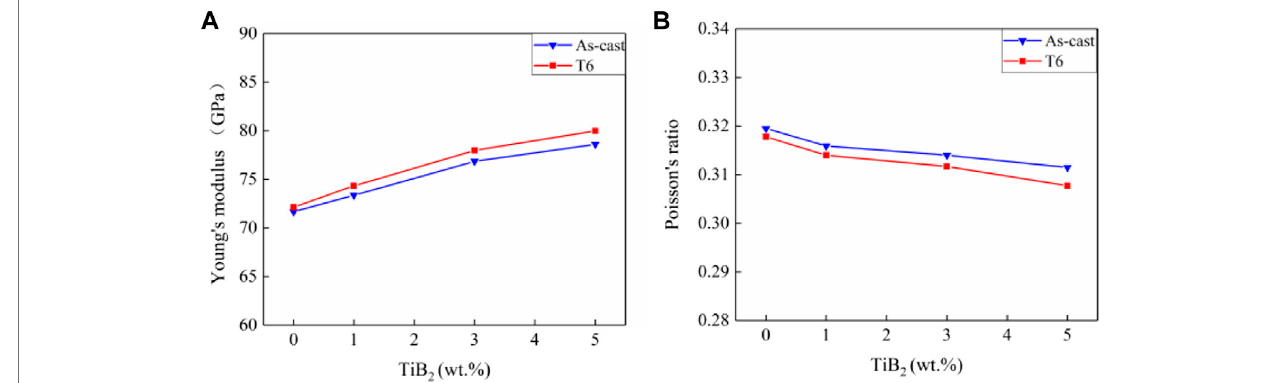
FIGURE 7 | Effect of TiB2 content on: (A) Young ’ s modulus, and (B) Poisson ’ s ratio of TiB2/A356 composites.